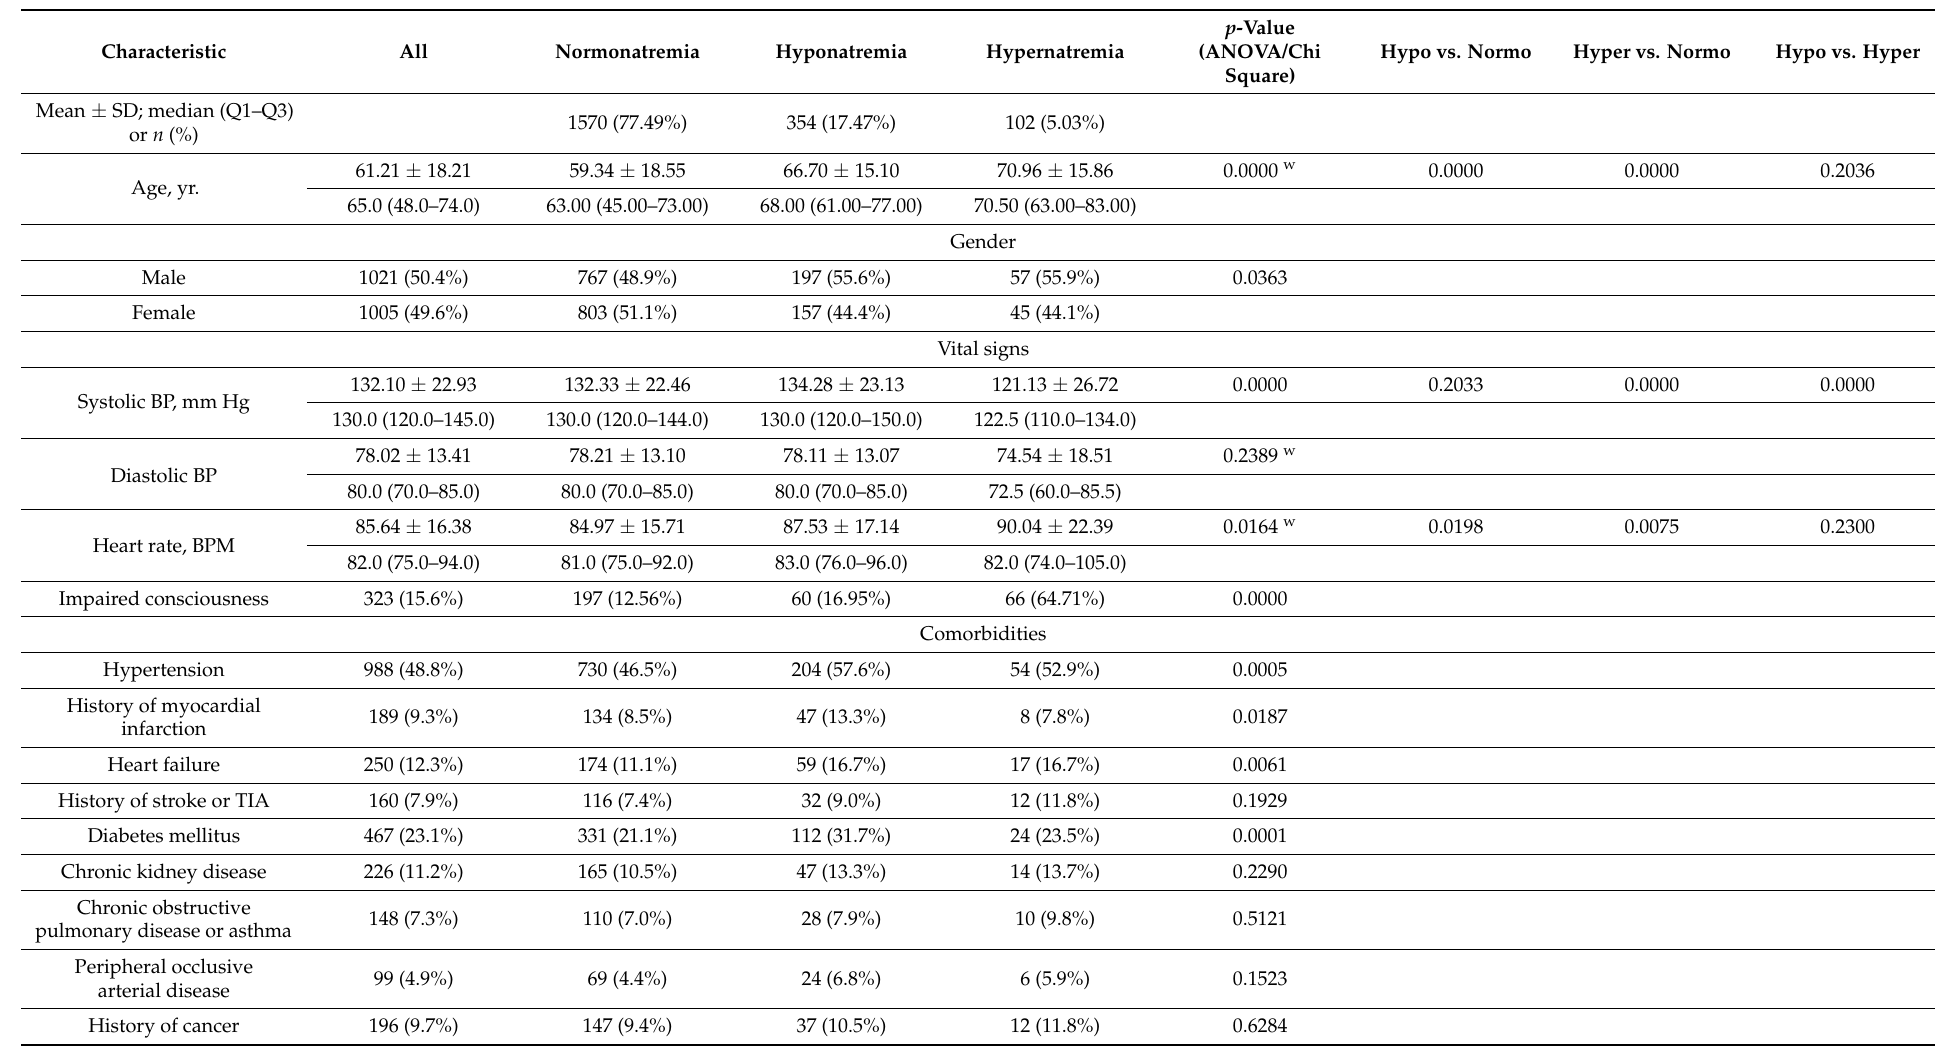
Table 1. Patient